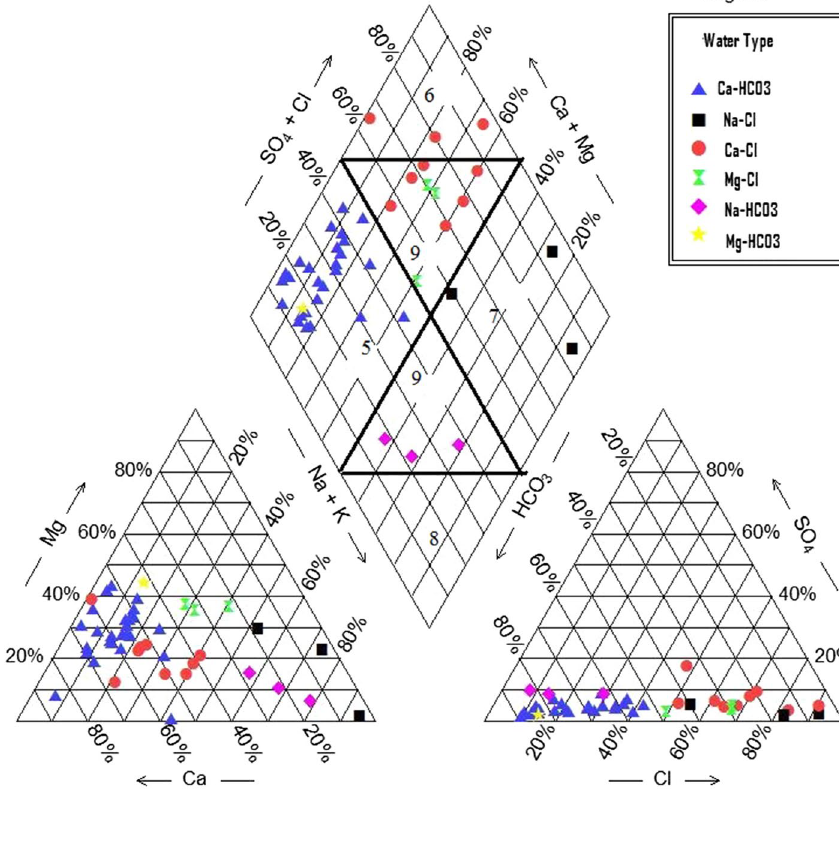
Fig. 11 Hydrochemical facies of groundwater in the wet